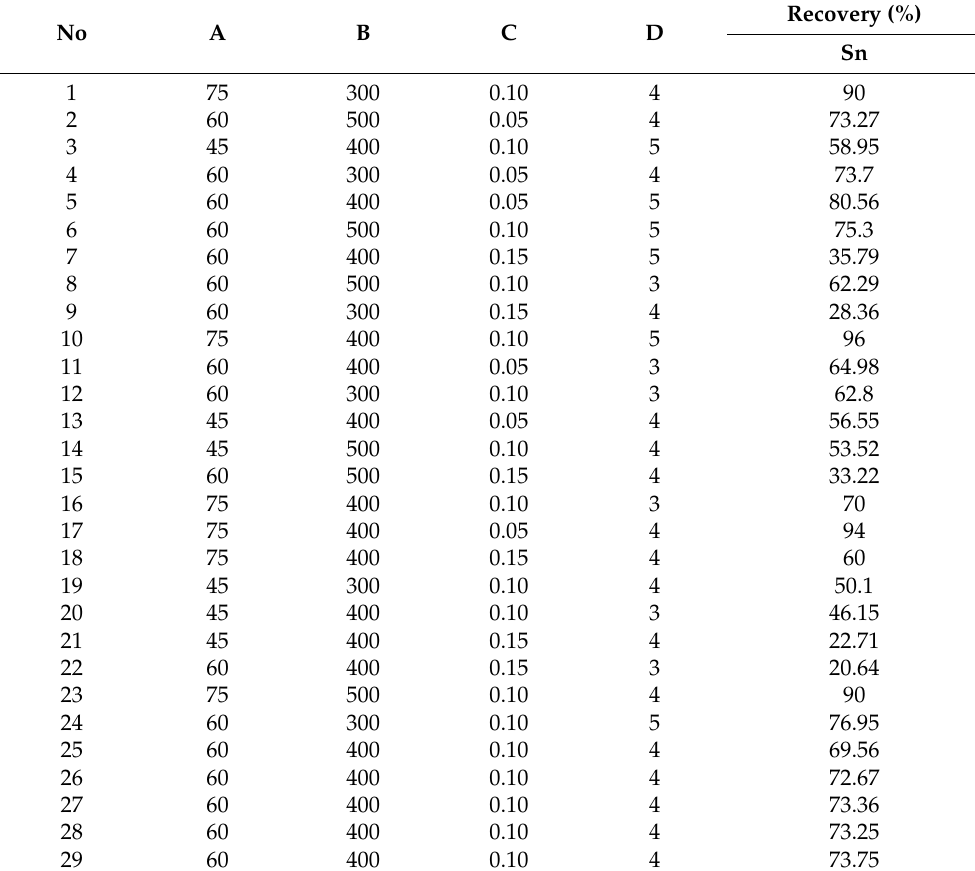
Table 3. BBD design with experimental condition and recovery of Sn.